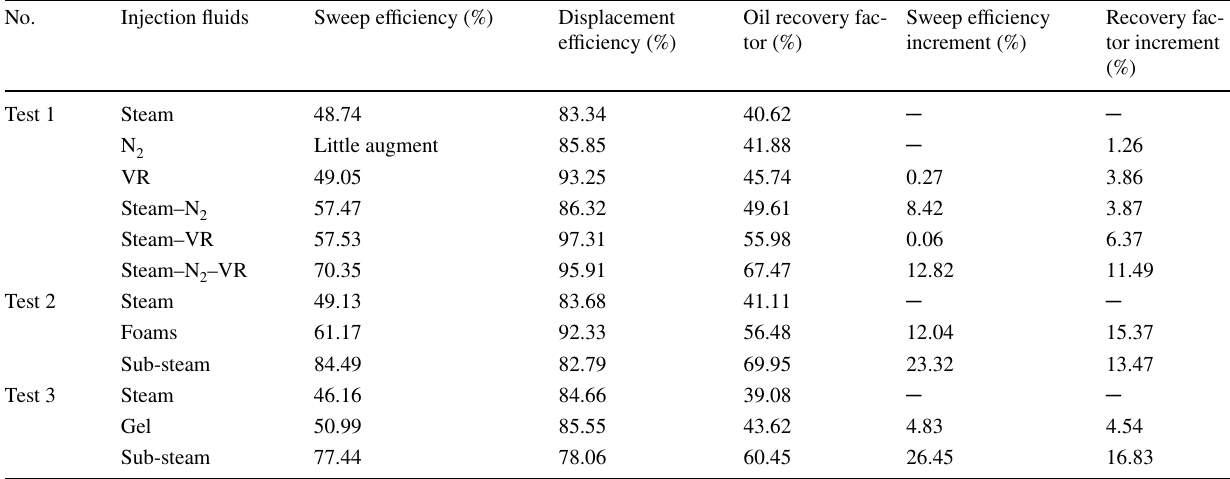
Table 3 The development effect during different fluid injection No. Injection